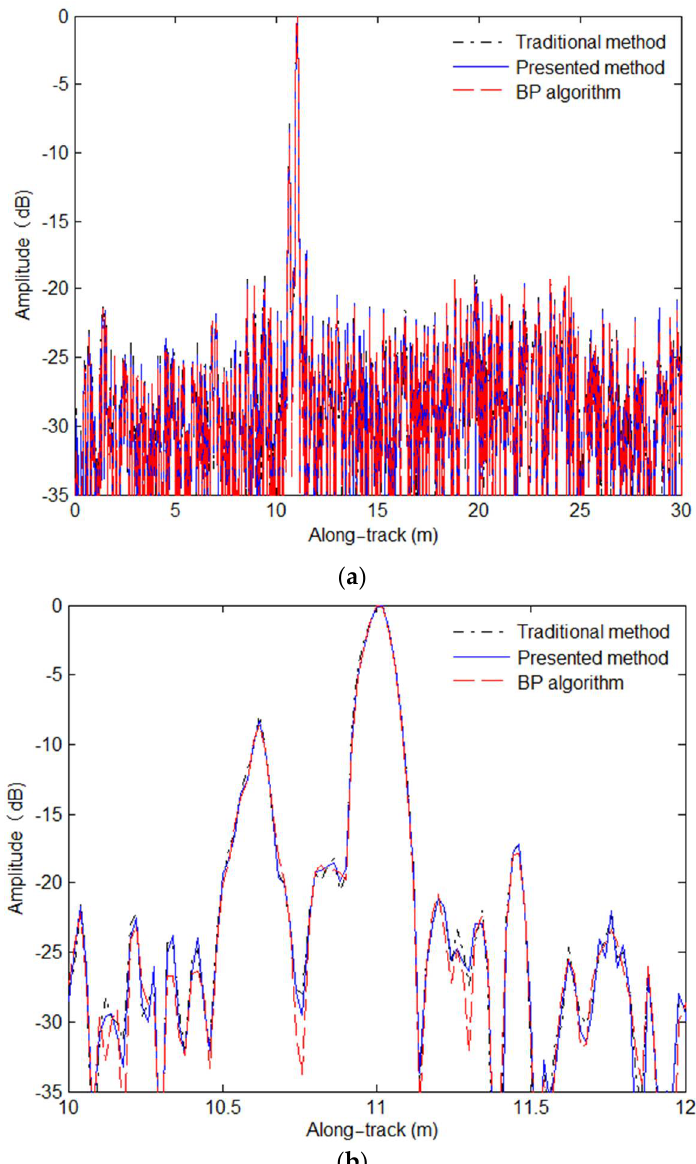
Figure 19. Cross-track slices of a target marked by a red circle in ( a ). ( a ) Global slices; ( b ) close look.